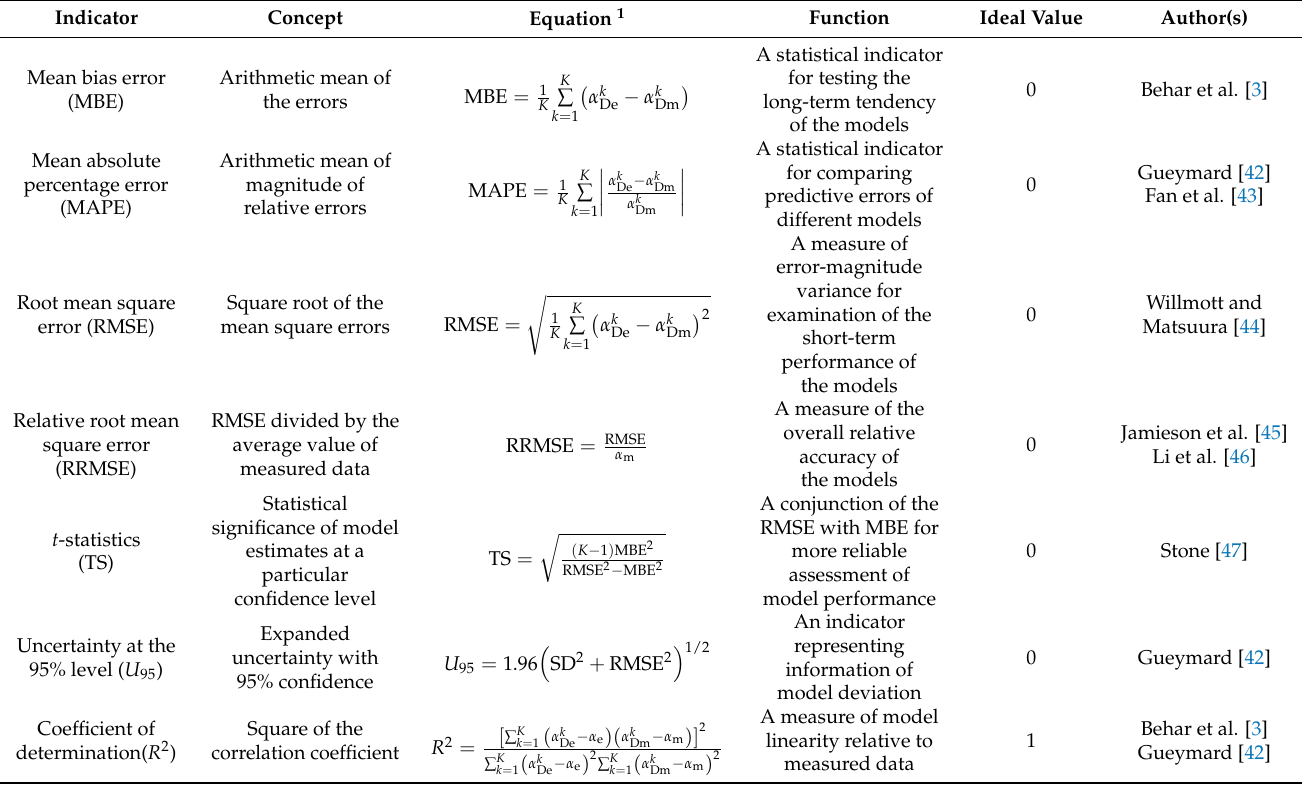
Table 2. Statistical indicators for performance evaluation of ground albedo models.